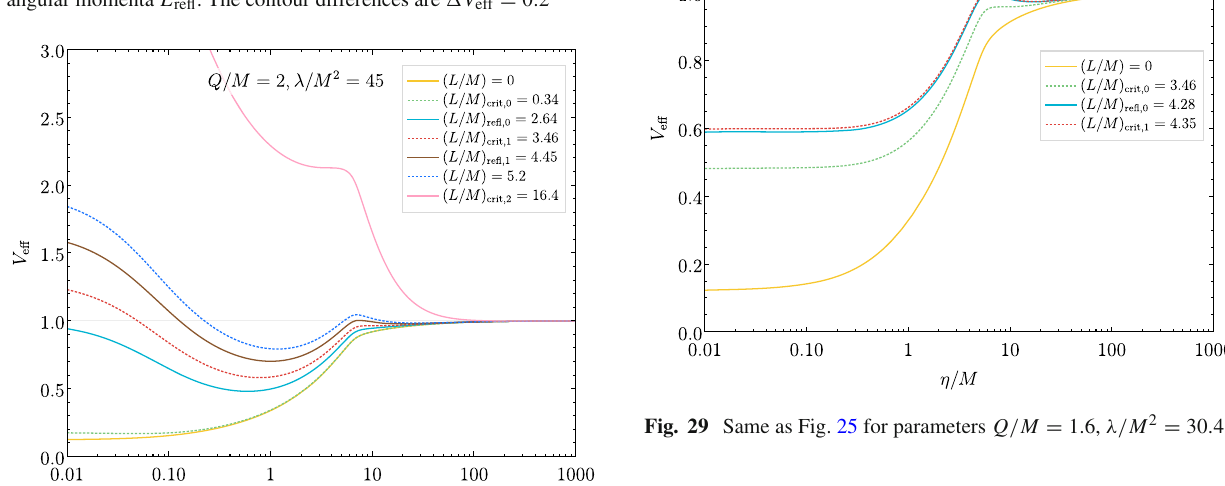
at the throat and bound orbits do no longer cross the throat.